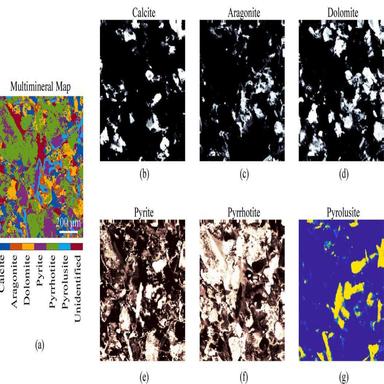
Mineral mixture (a) a multimineral map of all 6 minerals, calcite, aragonite, dolomite, pyrite, pyrrhotite, and pyrolusite, and an unidentified category, with a 5 μm resolution, and; (b–g) single mineral maps for each mineral where black (b–f) or blue (g) represents no presence. (For interpretation of the references to color in this figure legend, the reader is referred to the Web version of this article.)